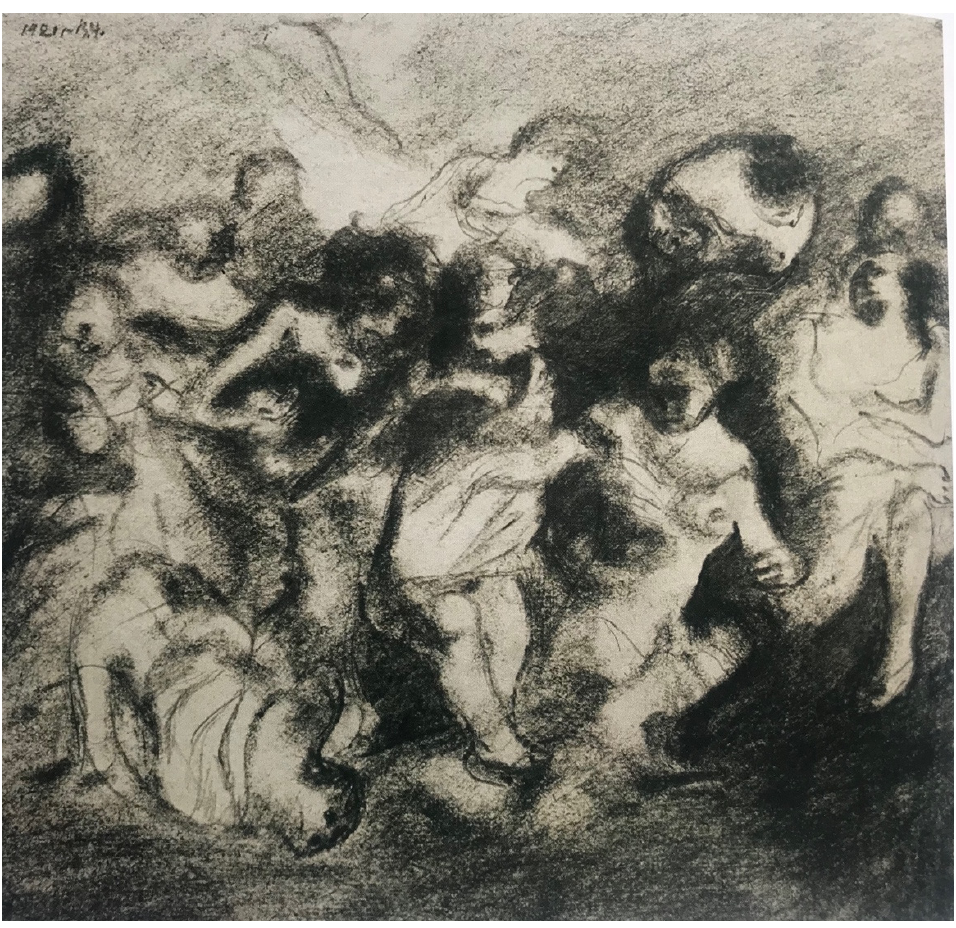
Figure 7. Vasily Chekrygin, The Raising of the Dead , 1920 – 1921, pencil and charcoal on paper, State Tretyakov Gallery, Moscow.